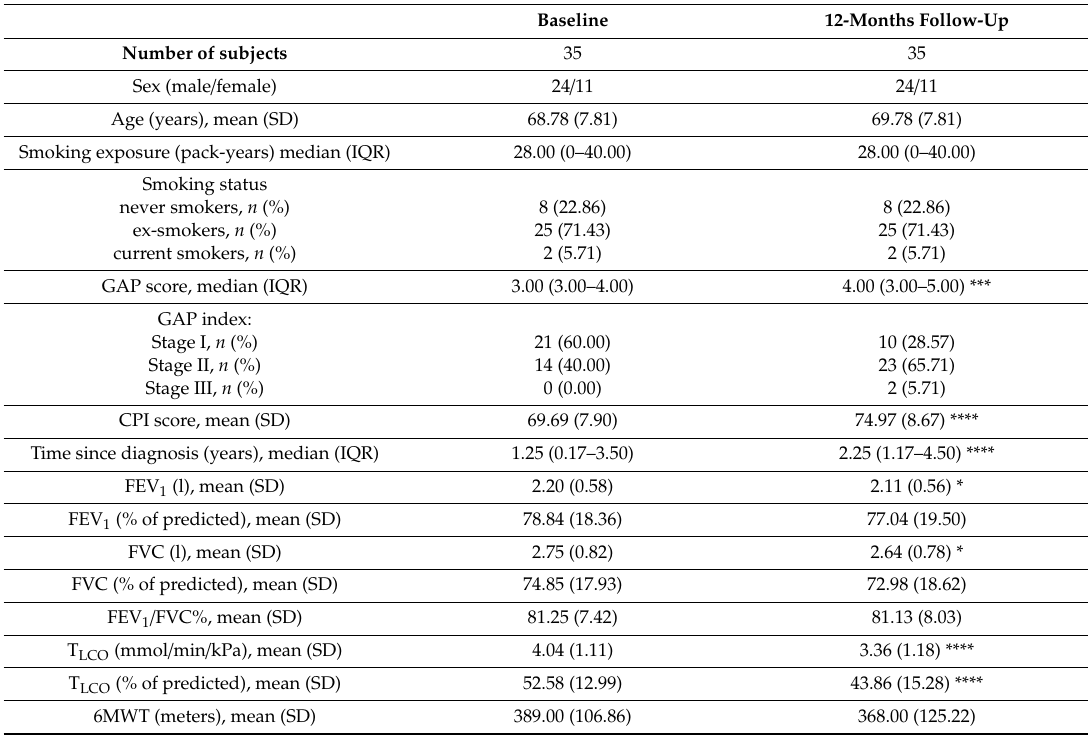
Table 2. Characteristics of the IPF follow-up